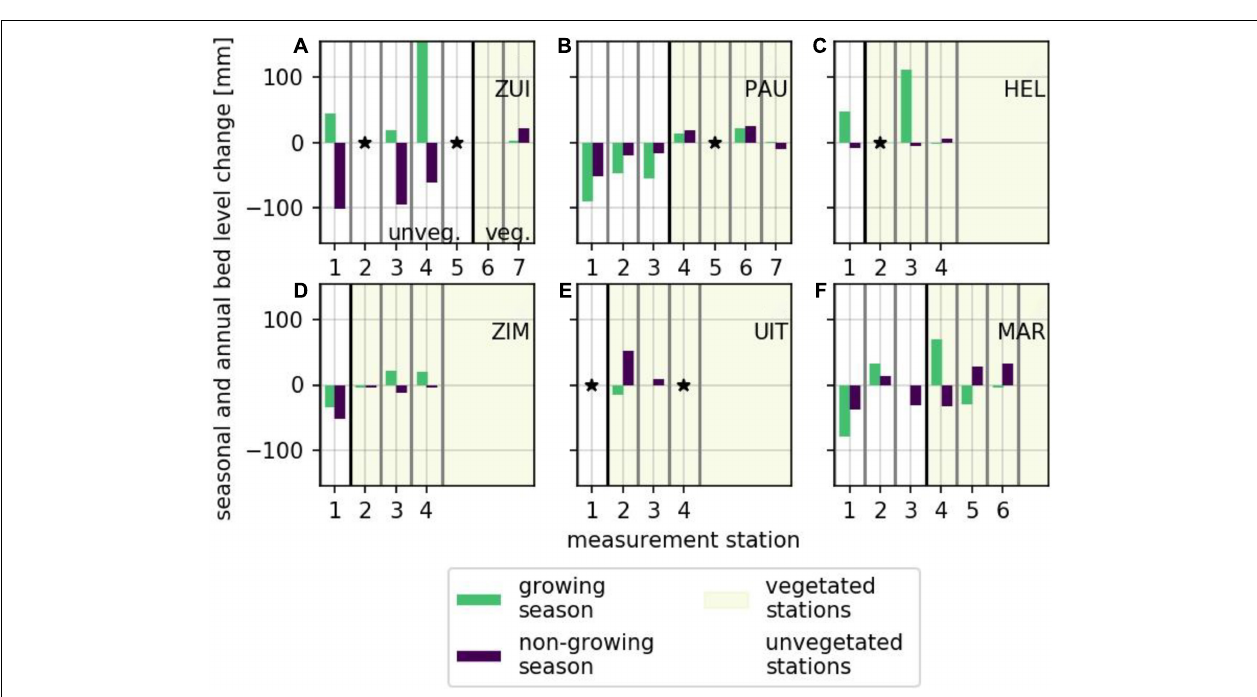
FIGURE 9 | Time series of bed level change (blue dots) at Zuidgors (left) and Marconi (right) at unvegetated stations (A–D) and vegetated stations (E,F) . The distance to the salt marsh edge (positive seaward and negative landward), is highlighted at the right-hand side of every subplot. The seasonal fit of the bed level change is indicated with a line and accompanied with a seasonal rate of change (purple for non-growing season and green for growing season).